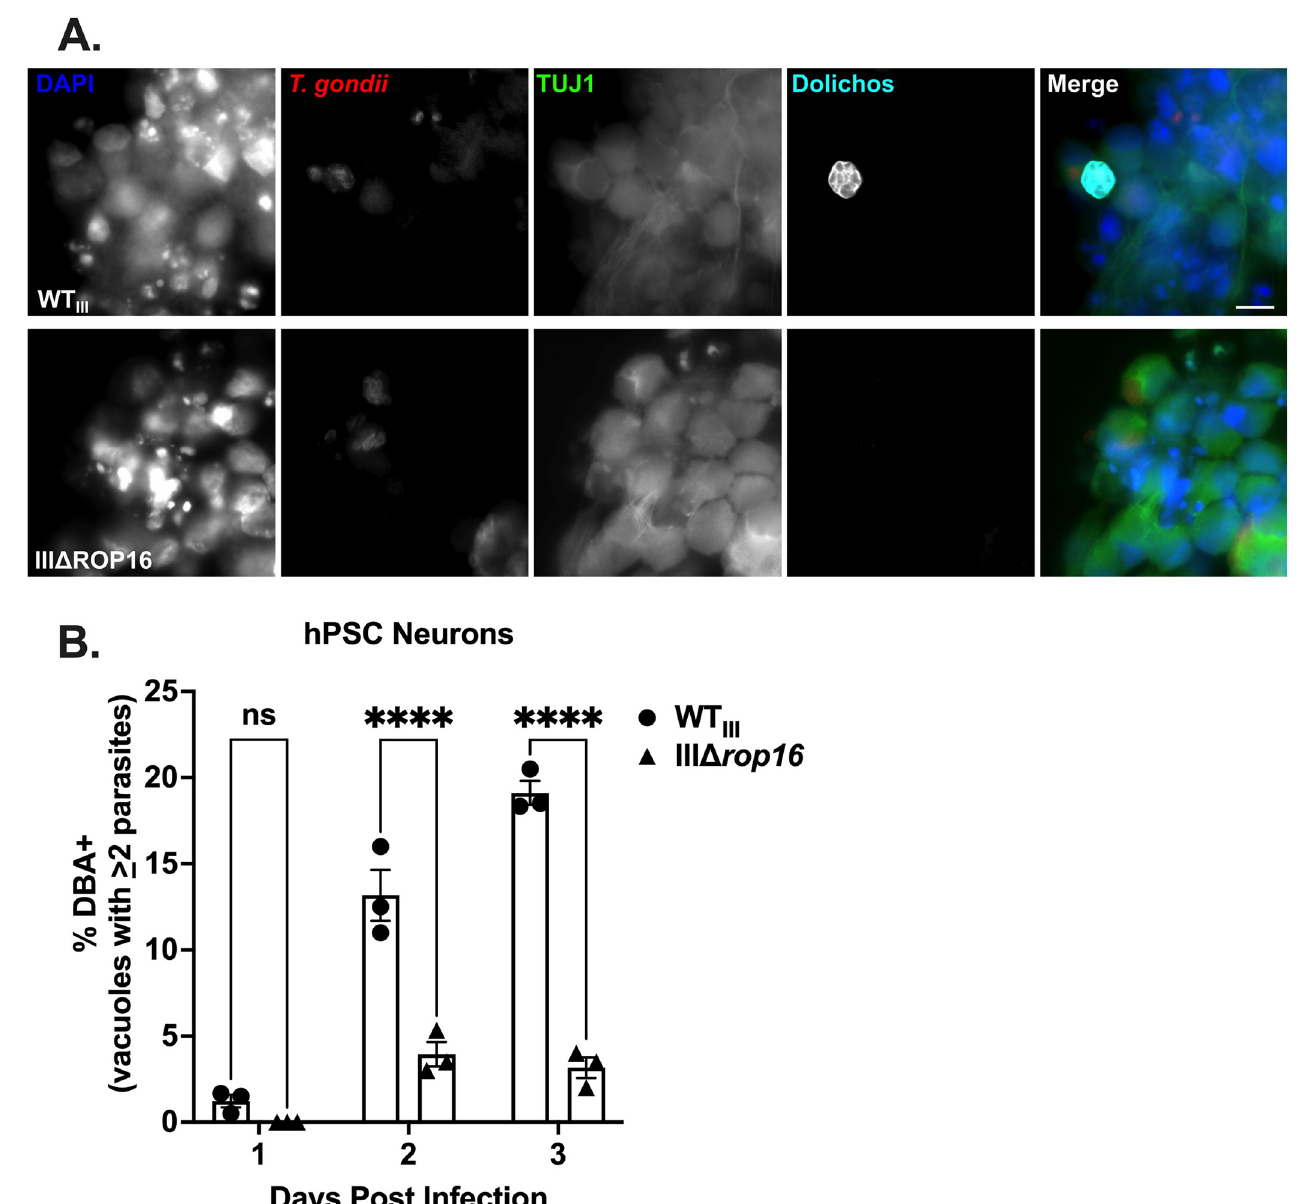
Fig 7. Deletion of ROP16 impairs cyst development in human neurons. (A) IFA of infected (3 dpi) human stem cell derived neurons (hPSC neurons). Images depict anti-TUJ1 (green, neurons), mCherry (red, parasites), DBA (cyan), and DAPI (blue). (B) Quantification of encystment at 1–3 dpi in hPSC neurons. Bars, mean ± SEM. N = 3 replicates/experiment, 3 independent experiments. **** p � 0.0001. ns = not significant, two-way ANOVA, Dunnett’s multiple comparisons test compared to WT III . Scale bar = 10 μ m.